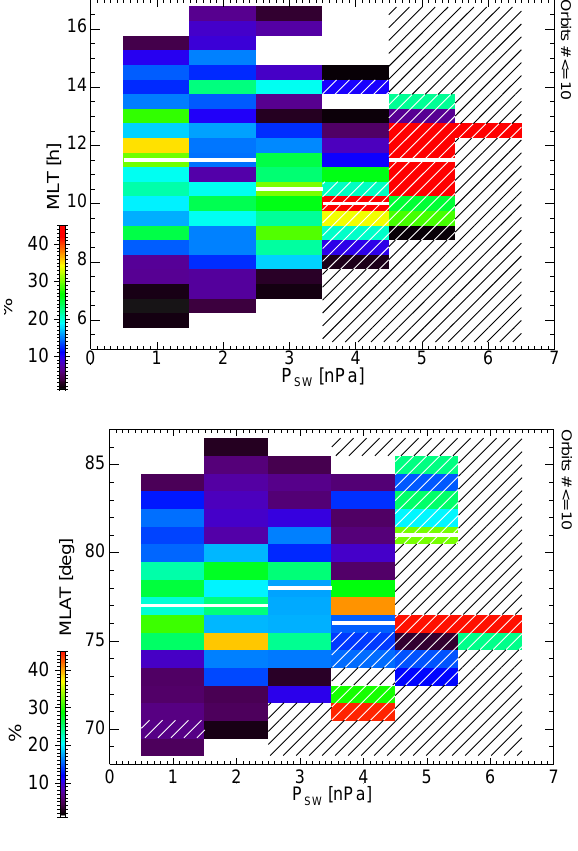
Fig. 7. The longitudinal (top) and latitudinal (bottom) cusp location as a function of the solar wind dynamic pressure.